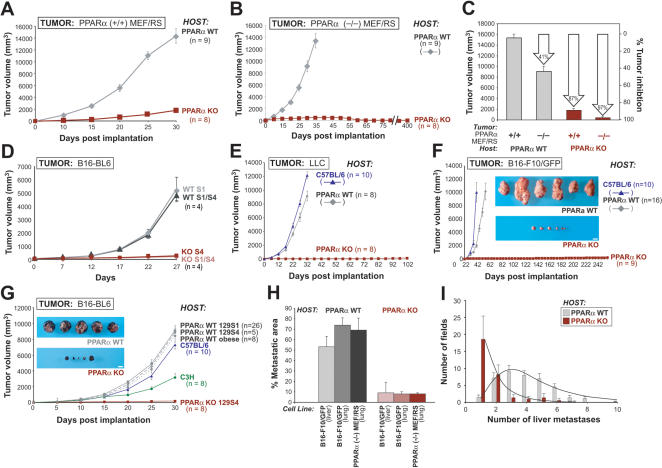
Tumor growth and metastasis are inhibited in PPARα knockout (KO) mice. PPARα wild type (WT) and PPARα KO mice were injected subcutaneously or intravenously with various tumor cell lines; (n) = number of mice/group. (A–C) The growth of engineered PPARα(+/+) MEF/RS and PPARα(−/−) MEF/RS tumors in PPARα WT and KO mice. (A) PPARα(+/+)MEF/RS tumor growth in PPARα WT (♦ gray) and KO (▪ brown) mice. (B) The growth curves of PPARα(−/−)MEF/RS in PPARα WT (♦ gray) and KO (▪ brown) mice.(C) Columns summarize the inhibitory effect of PPARα (−/−) tumor and host cells at day 30 post implantation (average±standard error of the mean). (D–F) The growth of different murine tumors in different mouse strains. (D) The growth of B16-BL6 melanoma was compared in WTS1 (♦ gray), WTS1/S4 (▴gray), KOS4 (▪ brown) and KO S1/S4 (♦ pink) strains. WT S1/S4, PPARα WT second generation littermates from PPARα WT 129/S1 and KO 129/S4; KO S1/S4, PPARα KO second generation littermates from PPARα KO 129/S4. (E) Lewis lung carcinoma growth in PPARα WT (♦ gray), PPARα KO (▪ brown) and C57BL/6 (▴ blue) mice. (F) B16-F10/GFP tumor growth in PPARα WT, PPARα KO and C57BL/6 mice, blue insets demonstrate representative B16-F10/GFP tumors in PPARα WT and KO mice on day 30 post implantation. Scale bar, 1 cm. (G) B16-BL6 melanoma was implanted in mice of indicated genetic backgrounds. Representative B16-BL6 tumors in PPARα WT (♦ gray) and PPARα KO (▪ brown) mice on day 30 post implantation are shown (blue insets). Scale bar, 1 cm. (H–I) Metastasis in PPARα WT and KO mice. H: Metastatic areas of B16-F10/GFP and PPARα(−/−)MEF/RS tumor cells at day 21 post-injection in lung and liver of PPARα WT (♦ gray) and KO mice (▪ brown). I: Number of liver metastases in PPARα WT (▪ gray) and KO (▪ brown) mice injected with B16-F10/GFP tumor cells (average±standard deviation).